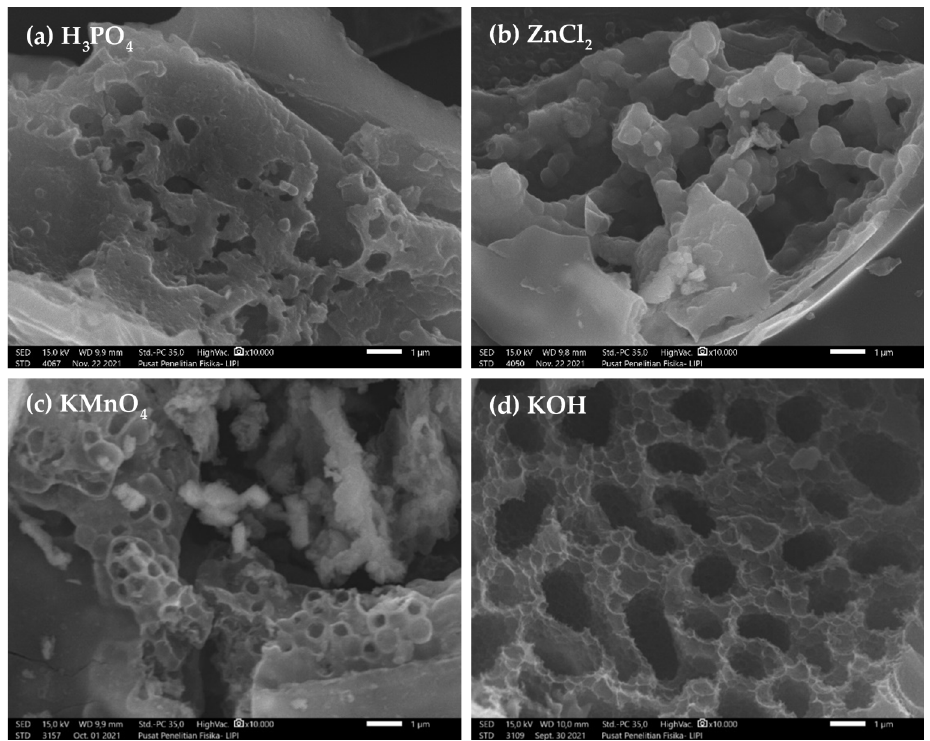
Figure 3. Scanning electron micrographs (10,000×) of activated carbons from sago waste prepared